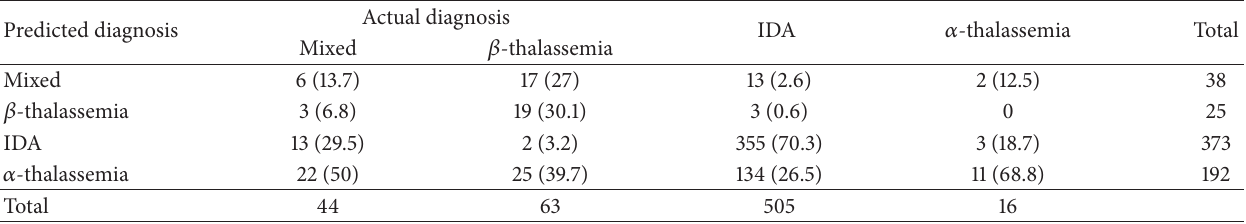
Table 3: Distribution of predicted versus actual disease classification in the validation set applying the classification type I. Number of patients (column %).